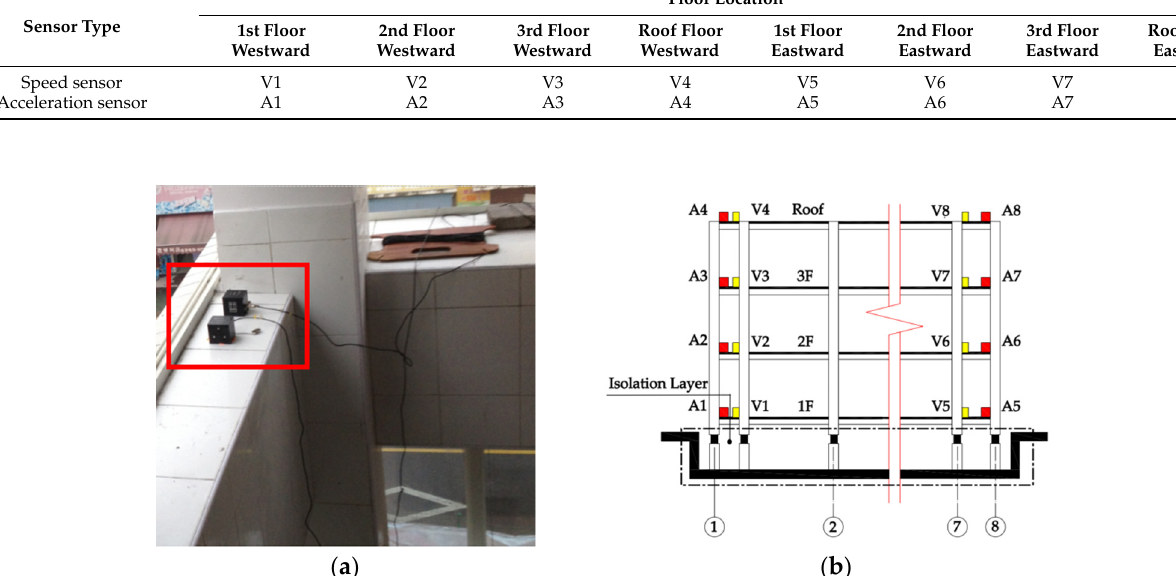
Figure 10. Sensors configuration: ( a ) field layout of sensors; ( b ) floor layout of sensors.